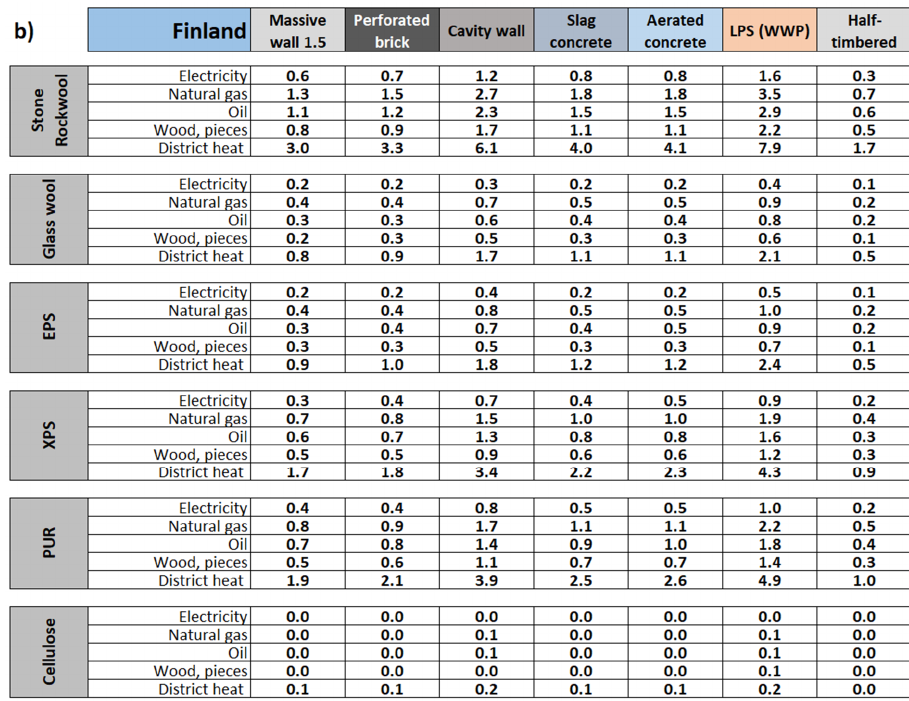
Figure 9. ( a ) CPP values chart for Finland. ( b ) CPP values for Finland. After averaging the data available from the EPDs available for Finland, PEFn values, Table 12. ( a ) Average CPP values for different energy sources. ( b ) Average CPP values for various insulation